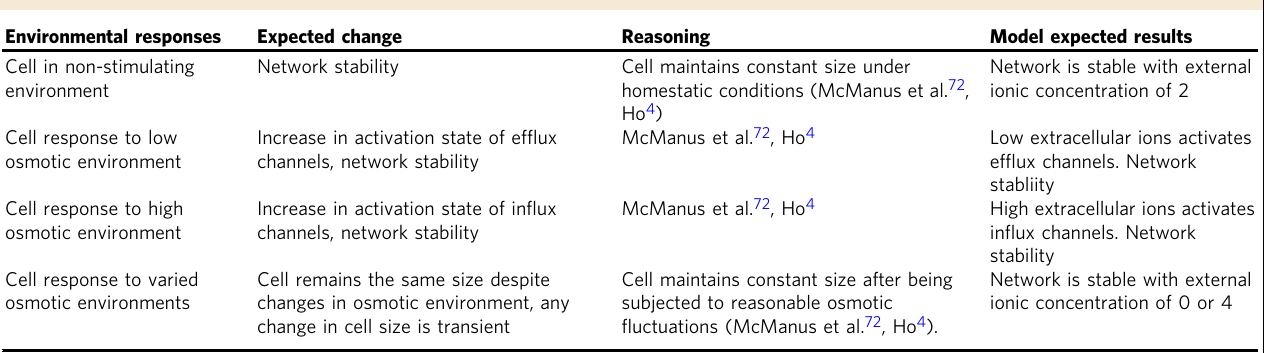
Table 2 Formal speci fi cation for base osmotic regulation model